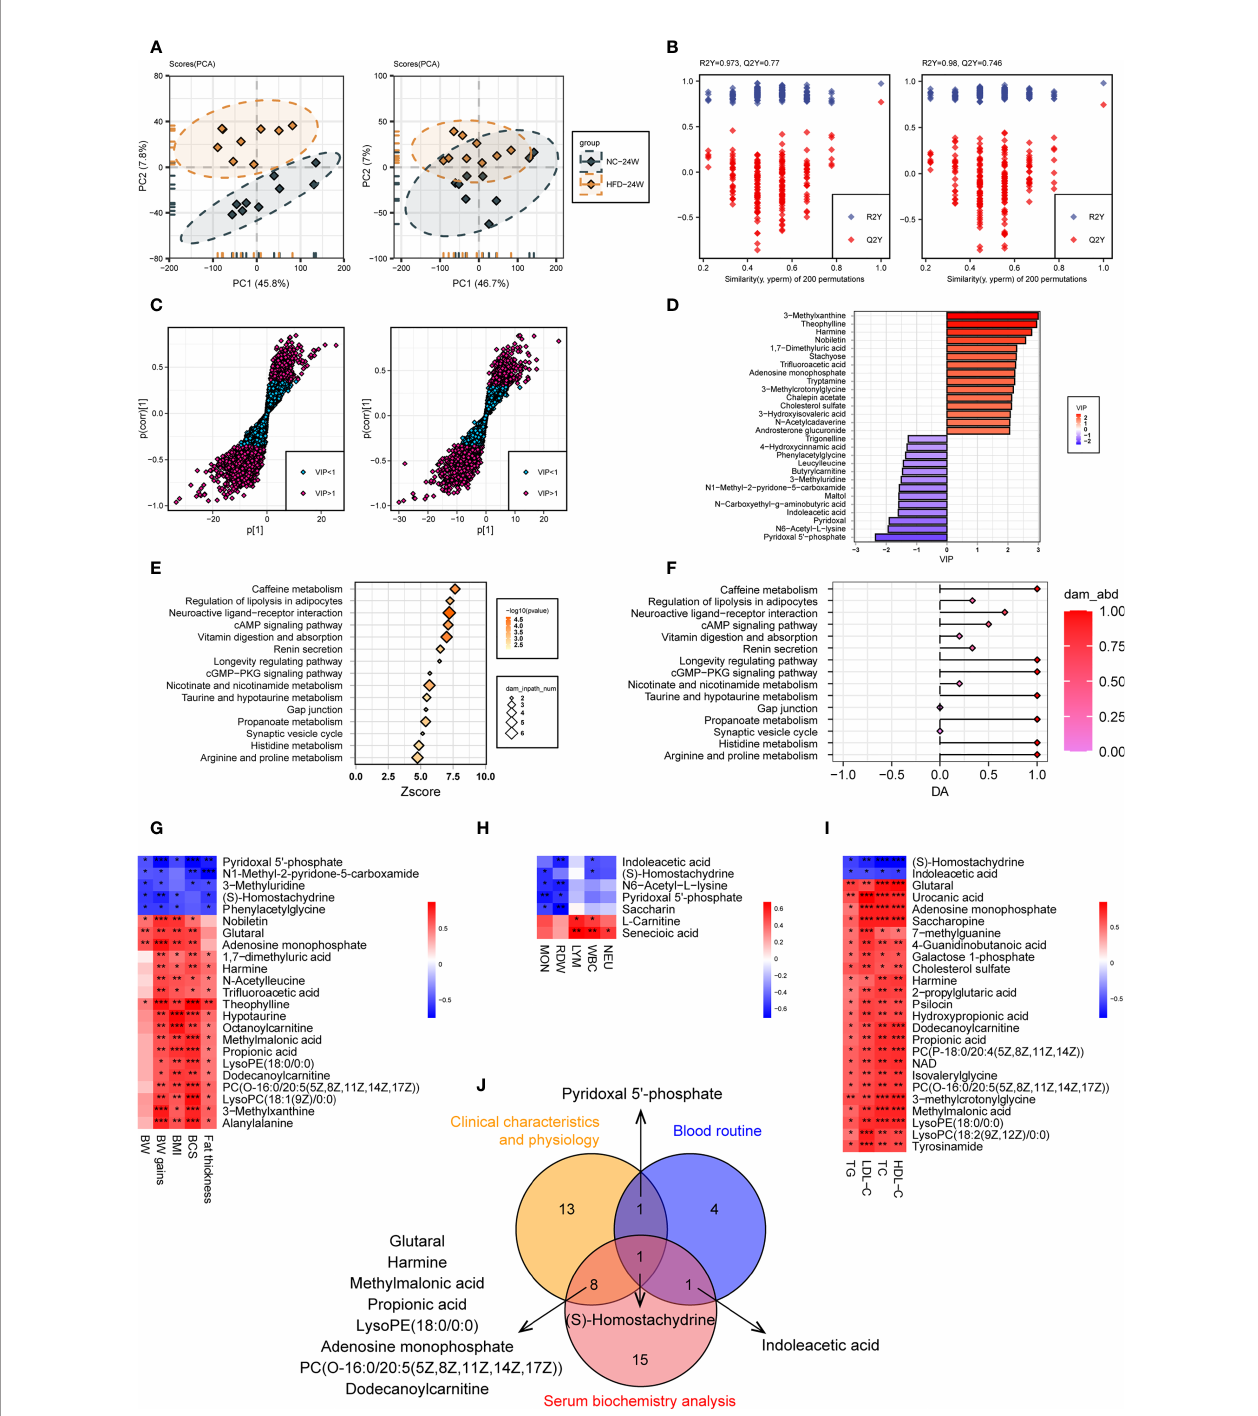
FIGURE 7 | Urine metabolome features related to HFD-induced metabolic disorder. (A, B) PCA (A) and OPLS-DA (B) of canine urine samples at 24 weeks in positive (left) and negative (right) ion modes, respectively. (C) Screening of differential metabolites based on VIP values in the OPLS-DA model in positive (left) and negative (right) ion modes. Signi fi cant difference was de fi ned as VIP>1 and P <0.05. (D) The endogenous differential metabolites with the highest fold change of expression after merging positive and negative ion patterns. (E – F) KEGG pathway enrichment analysis of 132 differential metabolites in 24-week urine (E) and DA score of these pathways (F) . (G – I) Heatmaps demonstrate the correlation between urine endogenous metabolites and canine phenotypes connected with metabolic disorders, including physical examination (G) , routine blood tests (H) , and serum biochemistry (I) . Signi fi cance levels * P <0.05, ** P <0.01, *** P <0.001. (J) Venn diagram for metabolites that were signi fi cantly associated with multiple